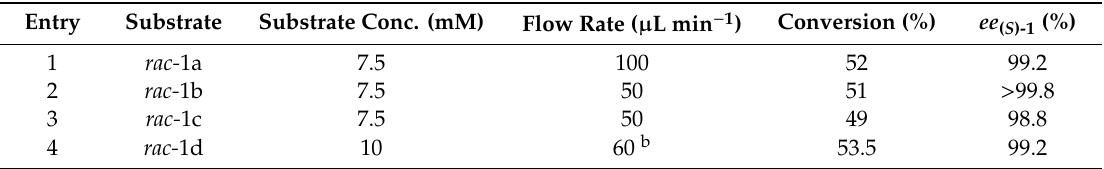
Table 3. Production of ( S )- 1a – d by kinetic resolution of rac - 1a – d with whole-cell immobilized AtR -TA under optimized conditions in continuous-flow mode a